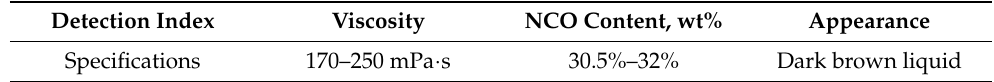
Table 1. Performance indexes of isocyanate.